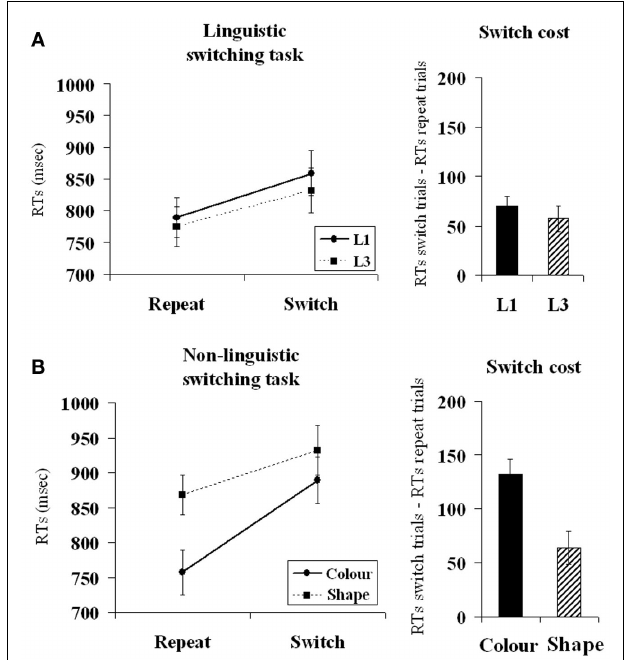
FIGURE 2 | (A) Performances on the linguistic switching task (left) and magnitude of the switch cost for L1 and L3 (right). Error bars represent SE. (B) Performances on the non-linguistic switching task (left) and magnitude of the switch cost for color and shape (right). Error bars represent the SE.